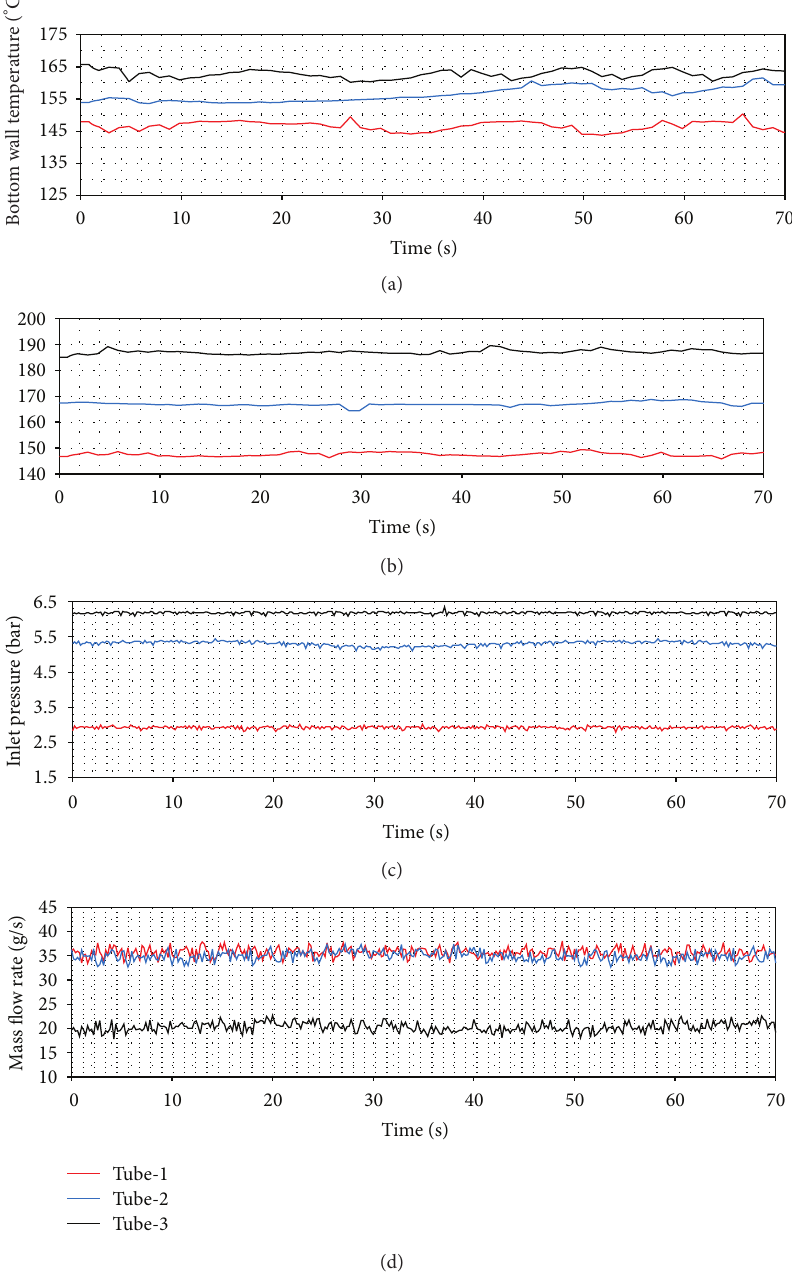
(d) kW, 𝑄𝑄 𝑄 𝑄𝑄 𝑇𝑇